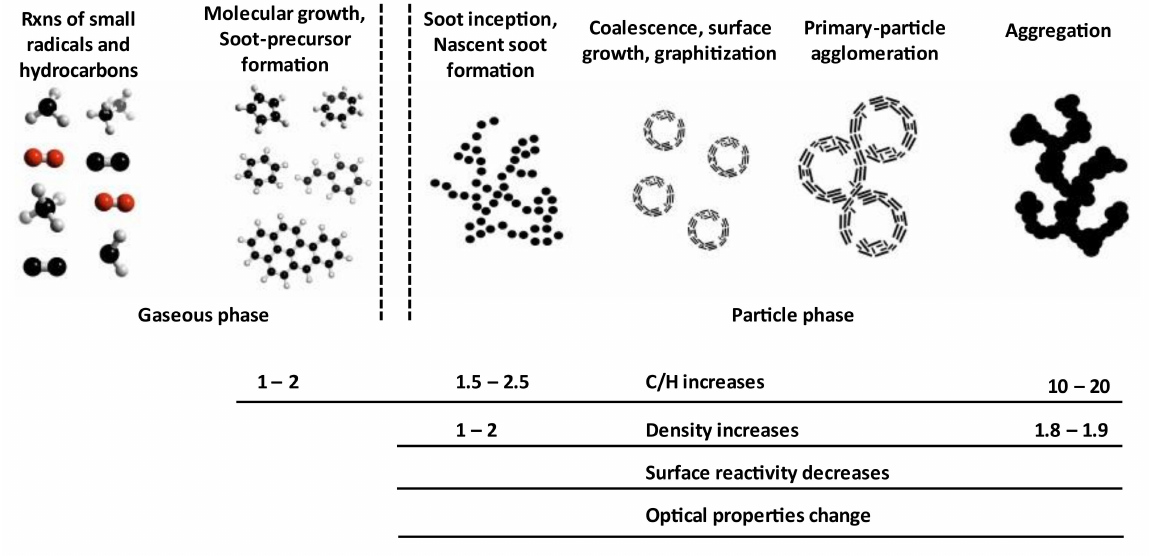
Figure 1. The soot formation and its